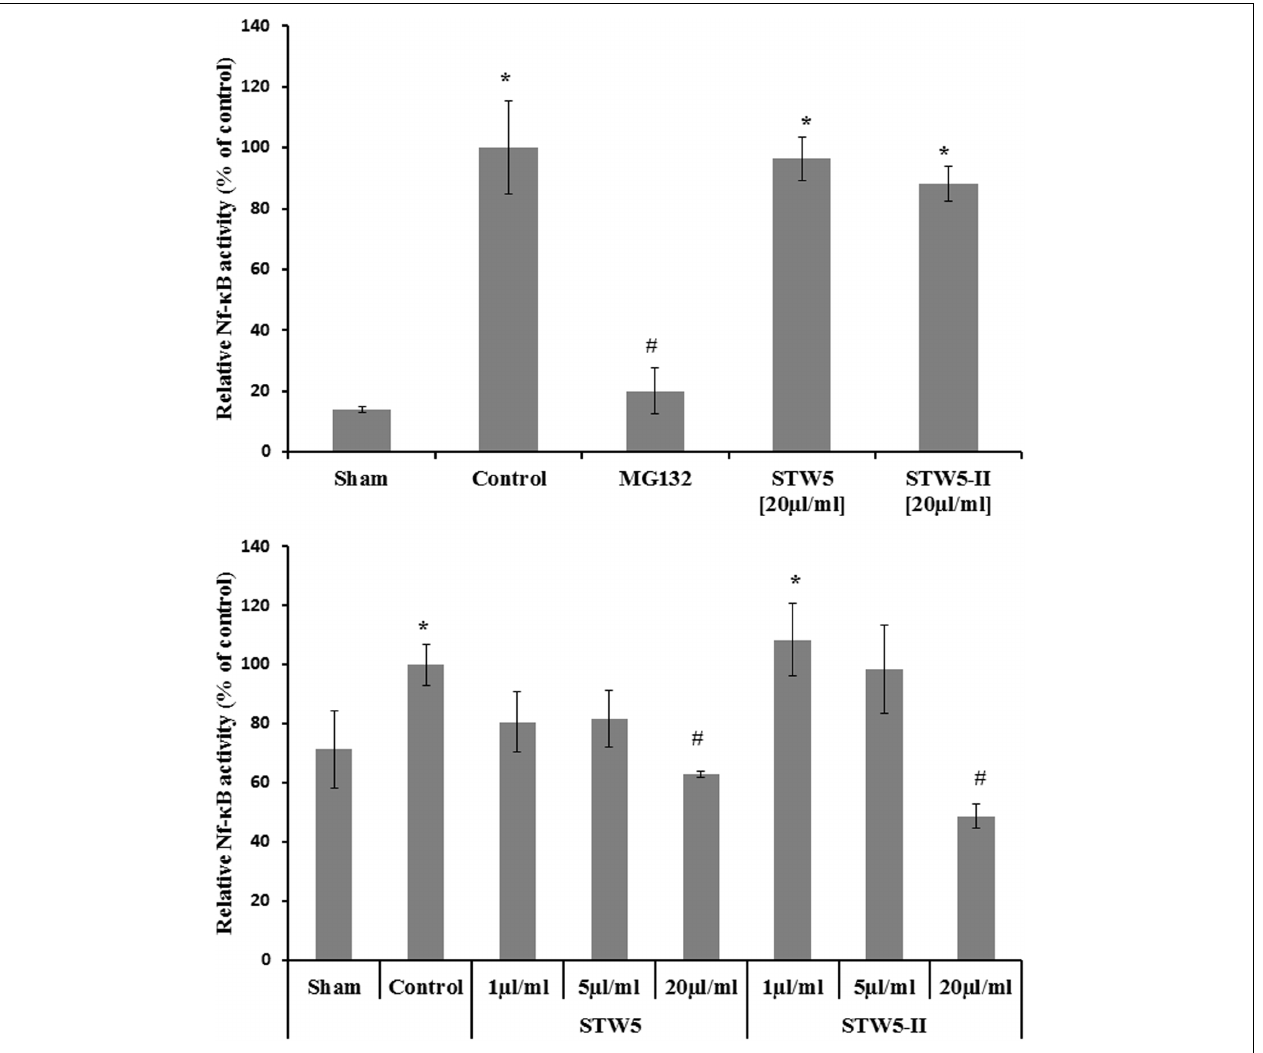
FIGURE 4 | Effects of STW5 and STW5-II on NF- κ B activity: The upper panel displays the NF- κ B activity measured by Quanti Blue assay in HEK reporter cells. The lower panel shows the level of activated NF- κ B in NCM460 cell extracts. # denotes statistical significance at p < 0.05 vs. control, ∗ denotes statistical significance at p < 0.05 vs.